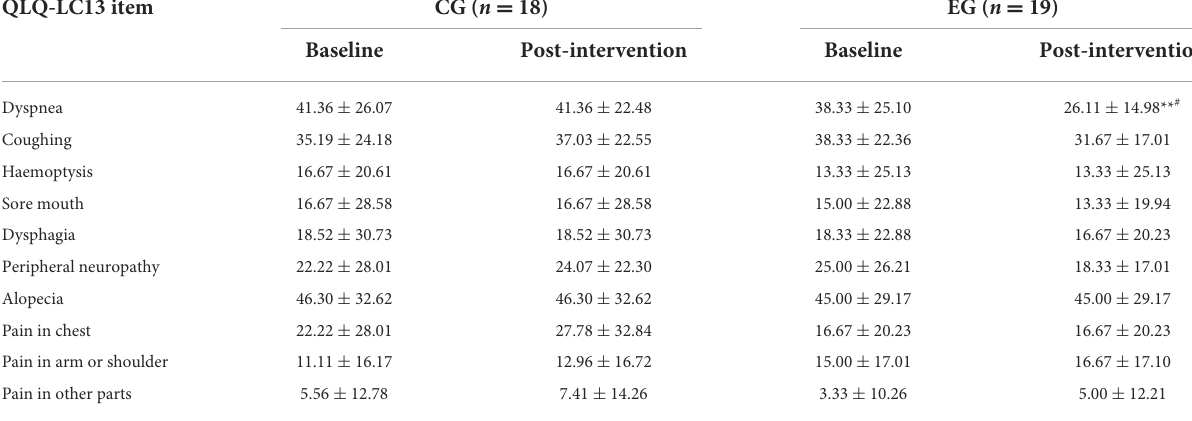
TABLE 6 The QLQ-LC13 scores of the CG and the